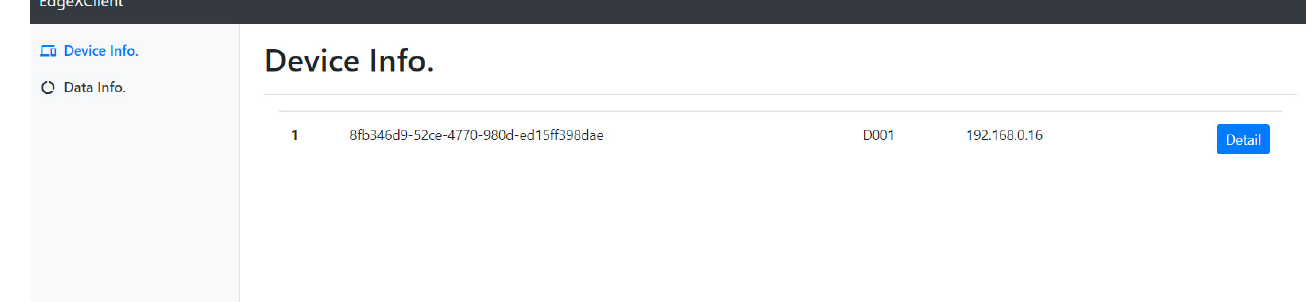
Figure 12. The Implemented Result of Device List of Client Services.